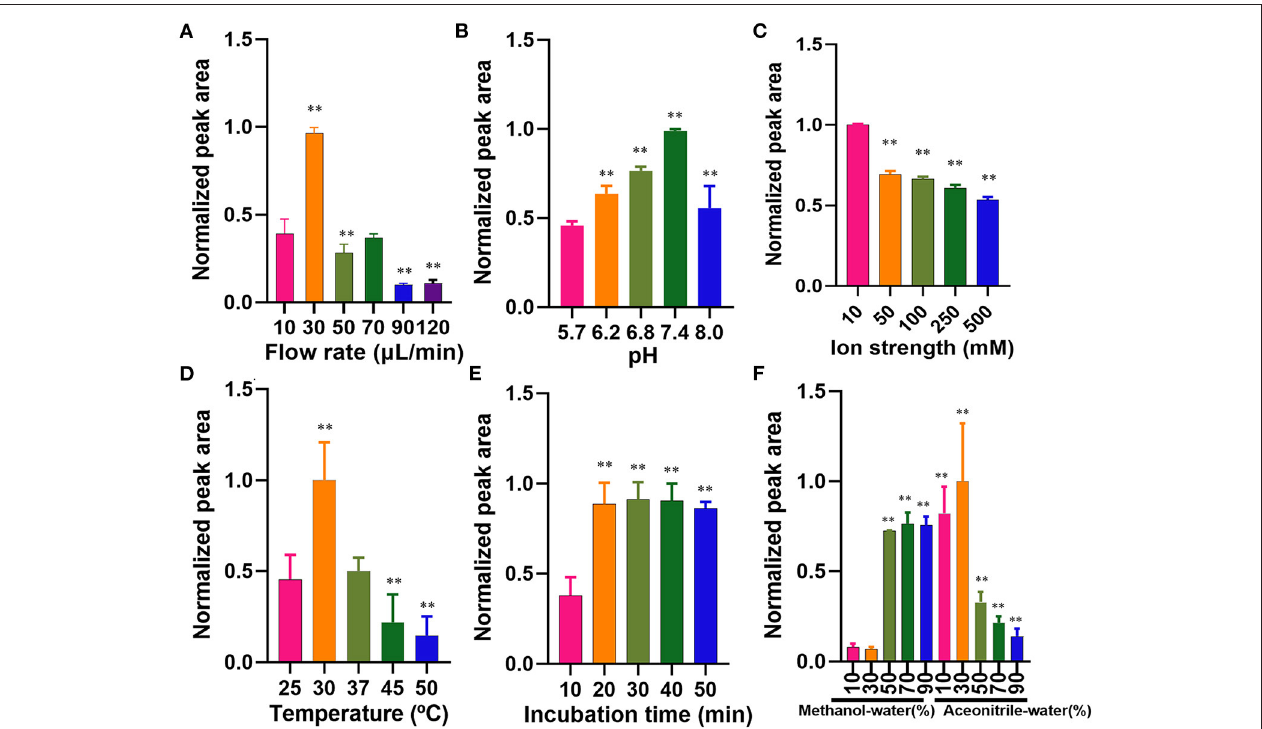
FIGURE 4 | Optimization of parameters affecting the microfluidic chip-based ligand screening system. (A) Flow rate, (B) pH profiles, (C) ionic strength profiles, (D) temperature profiles, (E) incubation time profiles, and (F) dissociated solvent. The symbol ** indicates P < 0.05 as compared with the first